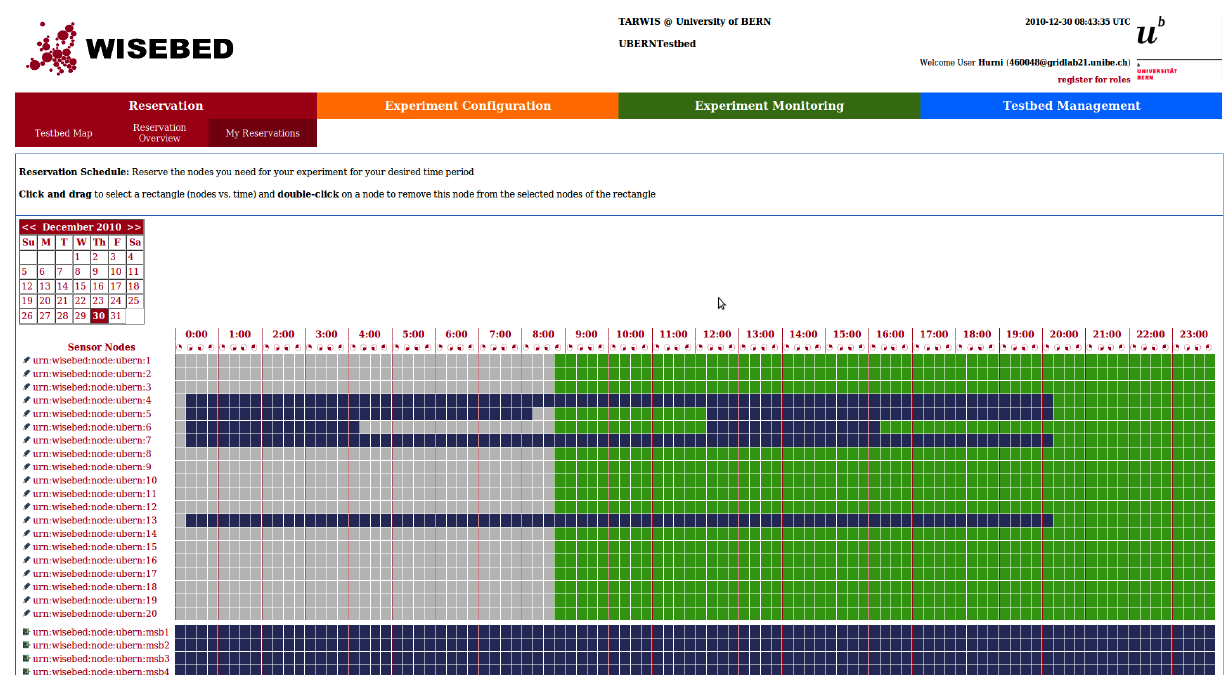
Figure 9. Reservations system GUI integrated into TARWIS GUI.